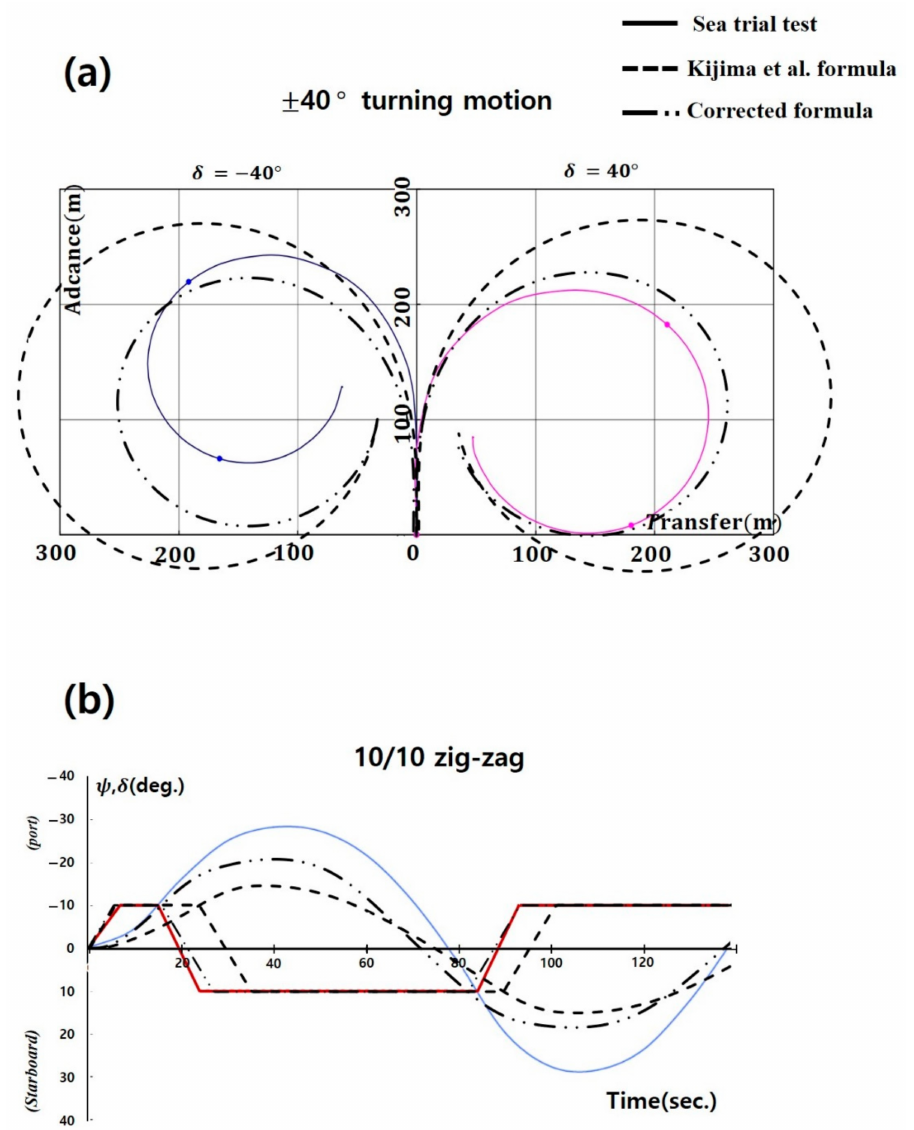
Figure 7. Comparison of turning motion ( a ) and 10/10 zig-zag ( b ) simulation